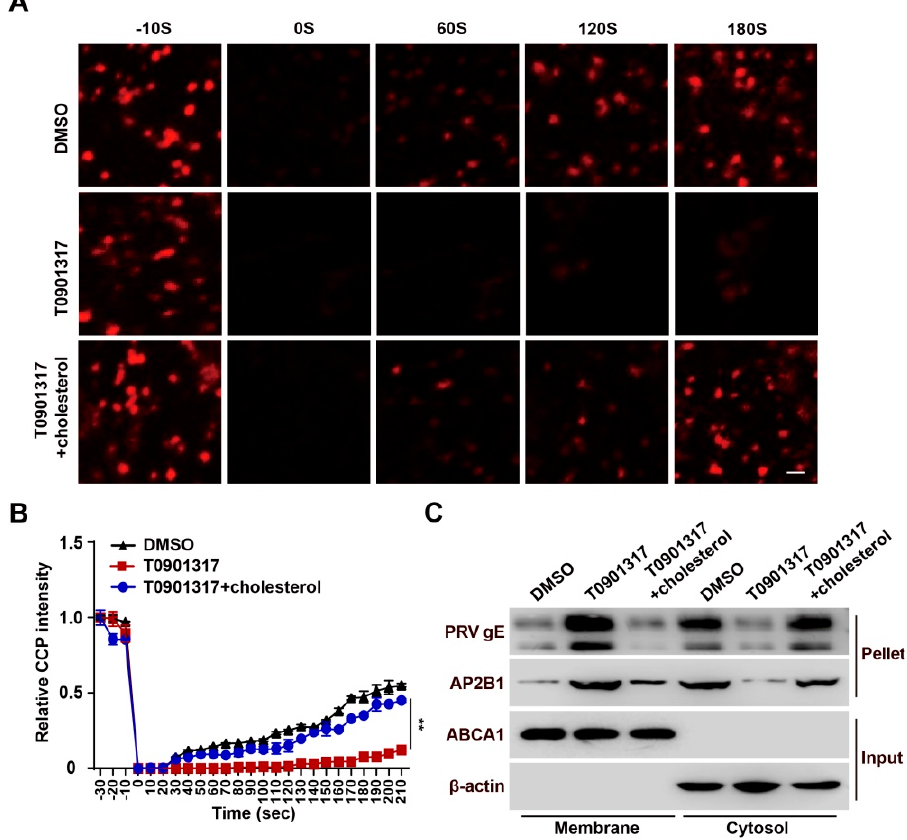
Figure 6. T0901317 blocks CCP dynamics-dependent viral entry. ( A ) HeLa cells were transfected with AP2B1-mCherry plasmid for 24 h followed by treatment with DMSO, T0901317 (6 μ M) and T0901317 (6 μ M) + cholesterol (0.003 μ g/mL) for a further 8 h. The CCP dynamics were assessed by FRAP analysis. Scale bar: 1 μ m. ( B ) Quantification of the relative fluorescent intensity of AP2B1 puncta in the FRAP region over time from ( A ) ( n = 10). ** p < 0.01. ( C ) PK-15 cells were incubated with PRV-QXX (MOI = 0.1) for 1 h at 4 °C and then in medium containing DMSO T0901317 (6 μ M) and T0901317 (6 μ M) + cholesterol (0.003 μ g/mL) at 37 °C. The internalization of PRV gE and AP2B1 was assessed by cell surface biotinylation assay after viral entry for 15 min.